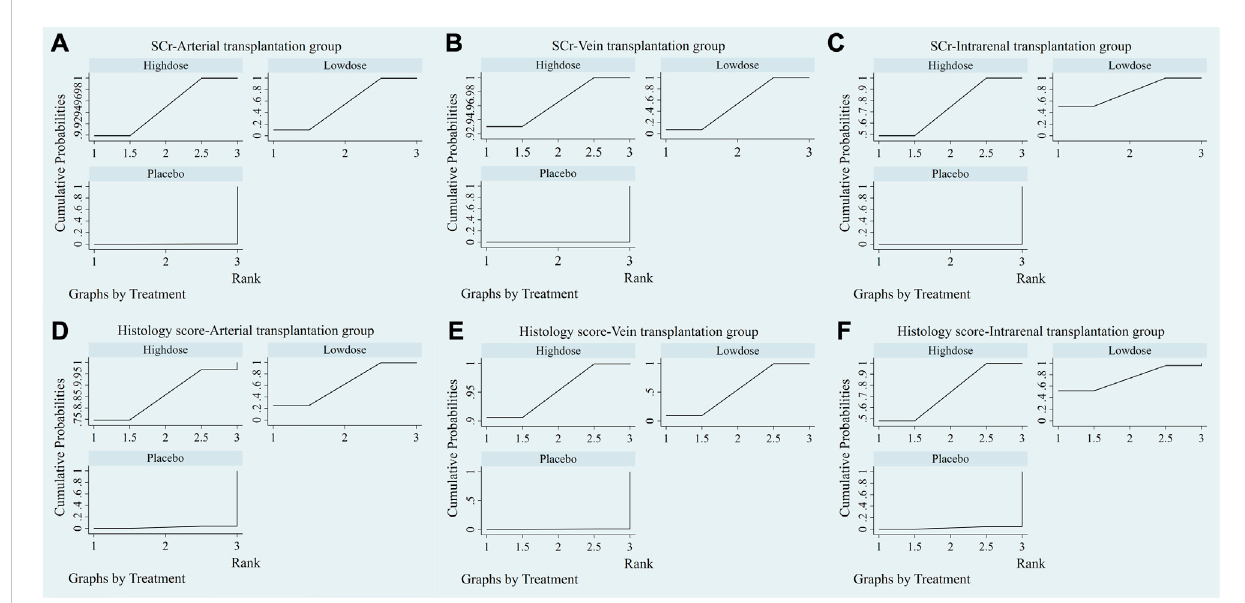
FIGURE 7 SUCRA plot of different transplantation doses. (A) SCr-Arterial transplantation group. (B) SCr-Vein transplantation group. (C) SCr-Intrarenal transplantation group. (D) Histology score-Arterial transplantation group. (E) Histology score-Vein transplantation group. (F) Histology score-Intrarenal transplantation group.